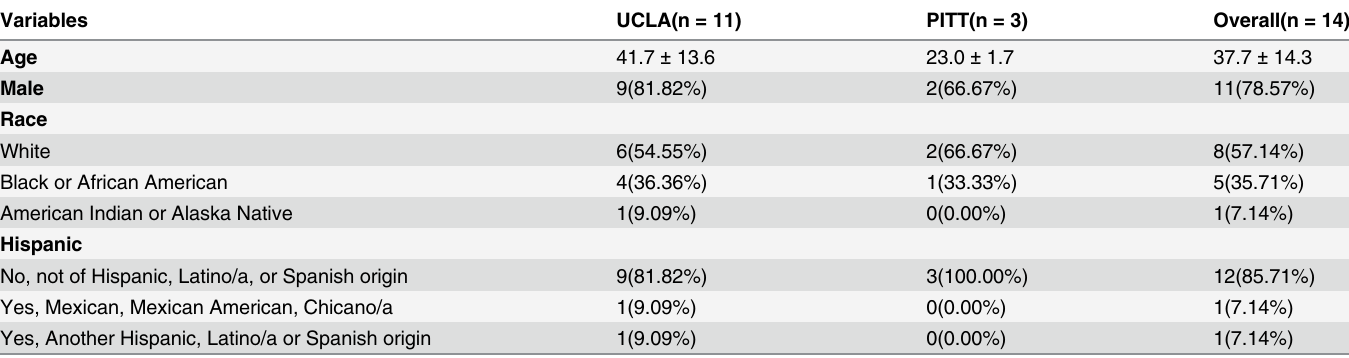
Table 1. Baseline demographic data by site.